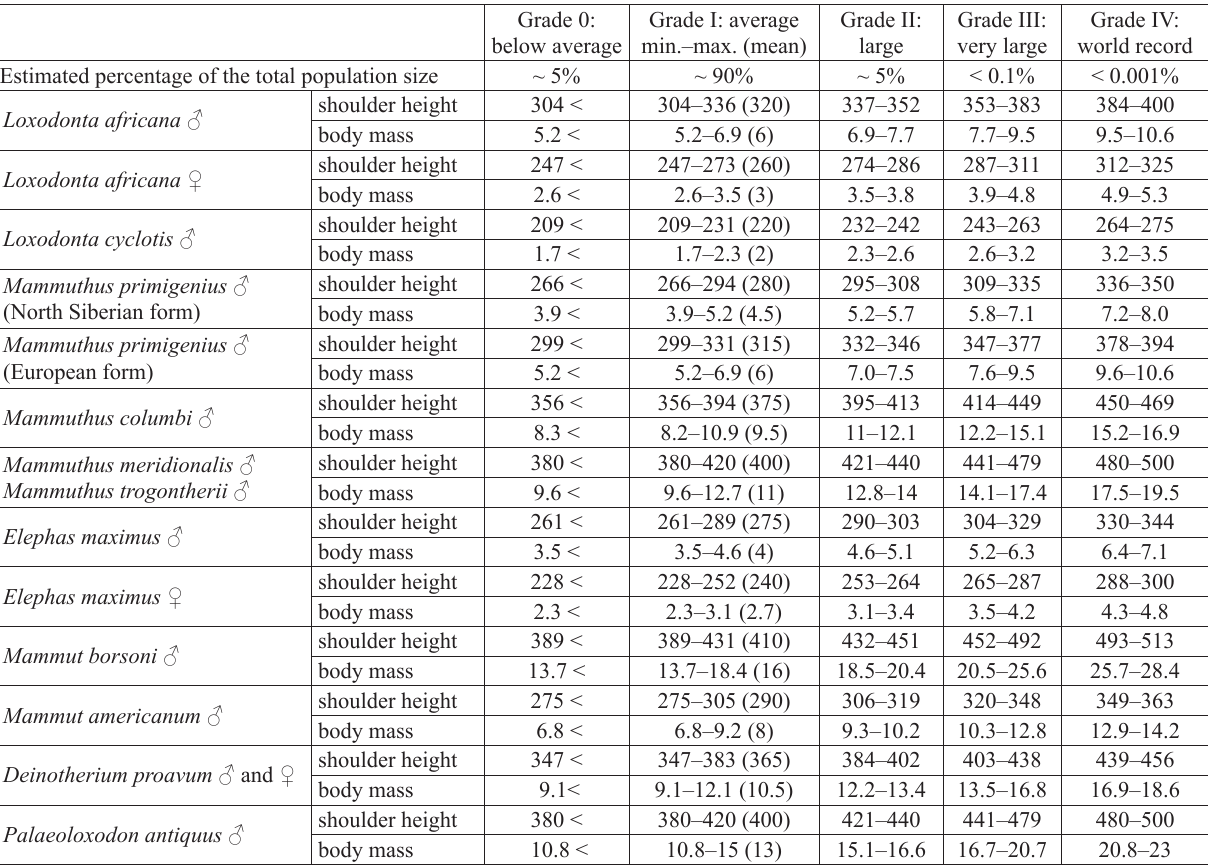
Table 8. Relationship between shoulder height (in cm) and body mass (in tonnes) of fully grown adult proboscideans of different taxa in optimal conditions from below average to record-sized